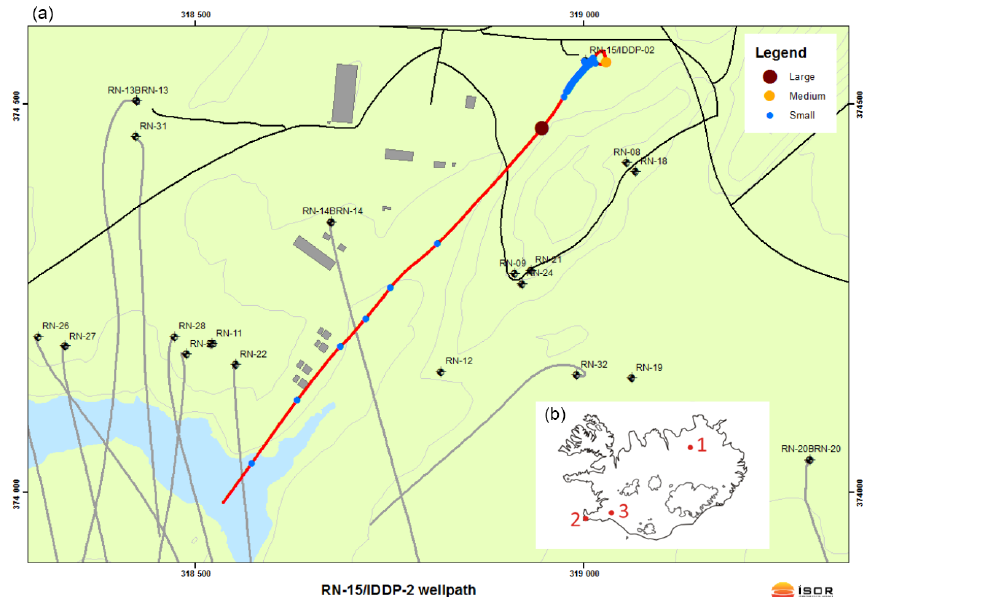
Figure 2. The locations and tracks of wells in the Reykjanes geothermal field (Weisenberger et al., 2017). The red line shows the track of well RN-15/IDDP-2. The relative size of the circulation loss zones are shown with circles (see legend). The inset (bottom right) shows the location of the geothermal fields at Krafla (1), Reykjanes (2), and Hengill